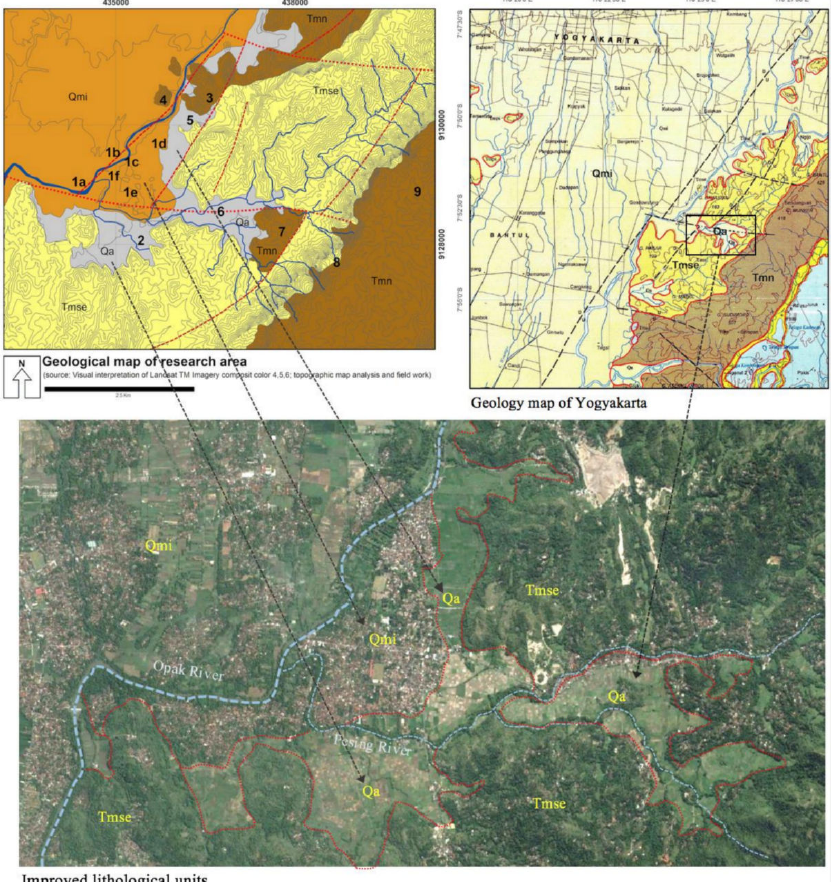
Figure 10. The improved geological map ( top left ), the geology map of Yogyakarta ( top right ), source: systematic geological map of Java, sheet Yogyakarta 1408-2 & 1407-5, scale 1:100,000, Edition 2, 1995. And the improved lithological units ( bottom